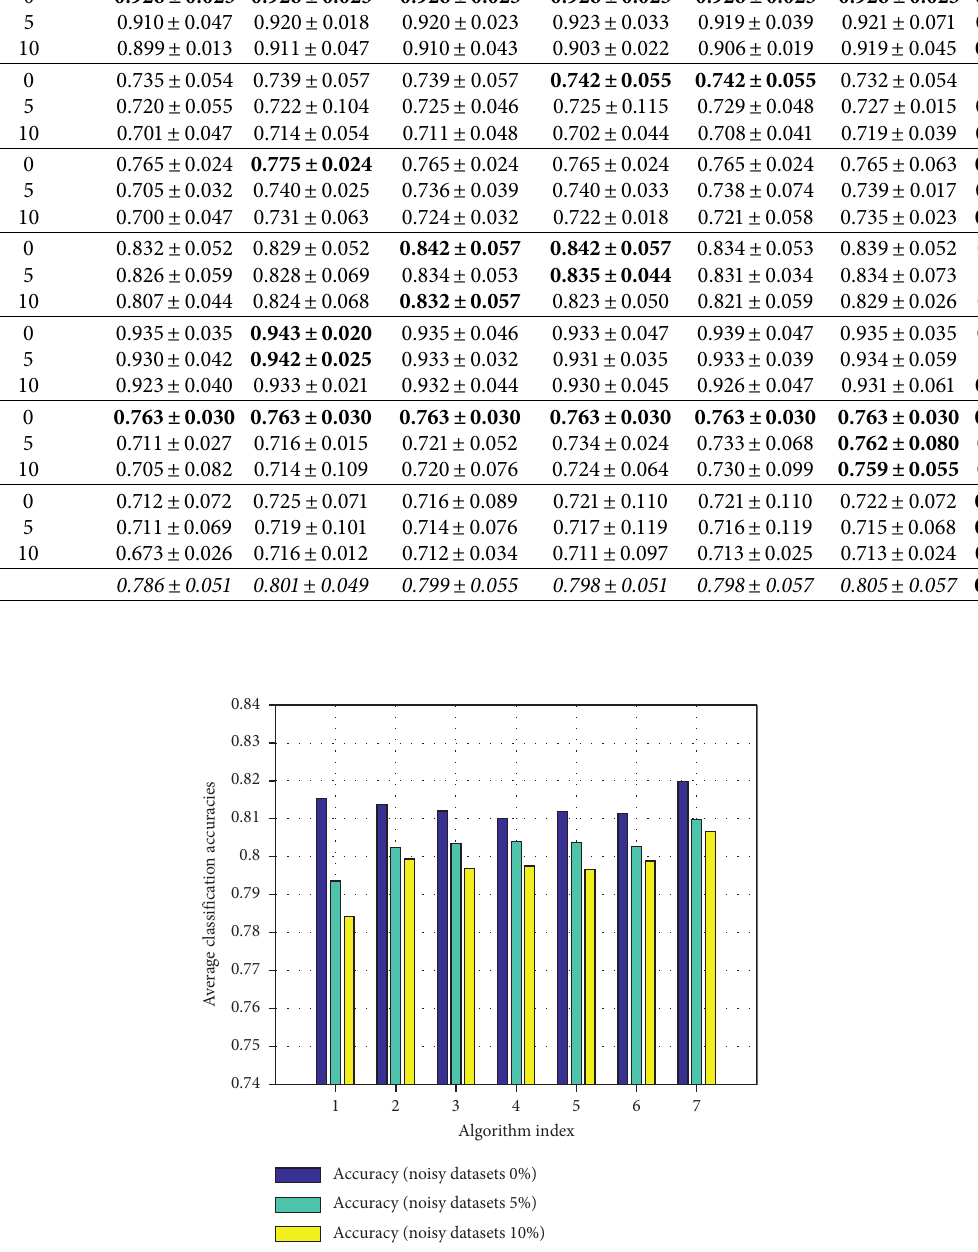
Figure 1: Comparison of robustness of different FRS models on